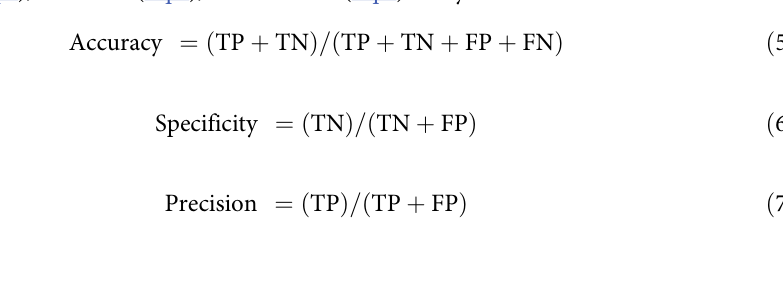
This paper analyzes the performance of classification using indexes including Accuracy (Eq 5), Specificity (Eq 6), Precision (Eq 7), and F1-score (Eq 8). They are calculated as follows: